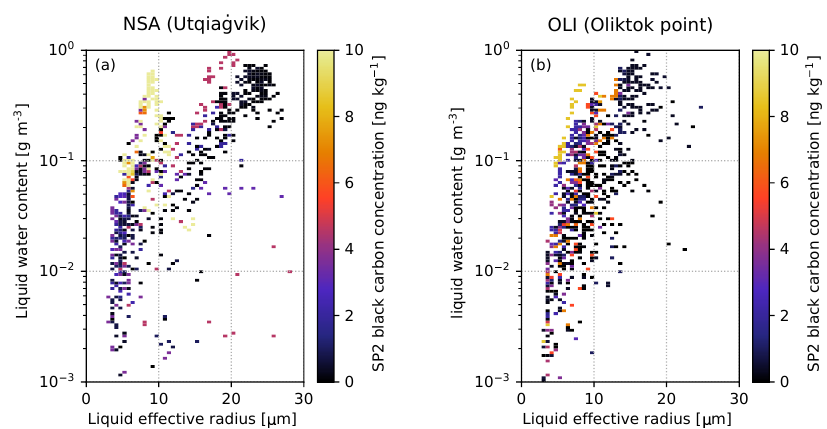
Figure 8. As Fig. 4, but with absolute values for SP2 refractory black carbon rBC concentration for (a) NSA and (b) OLI.